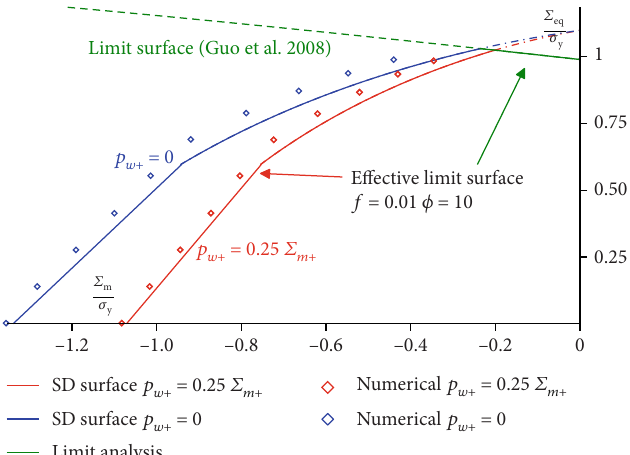
: 25 Σ m + . The friction w + = 0 and 0